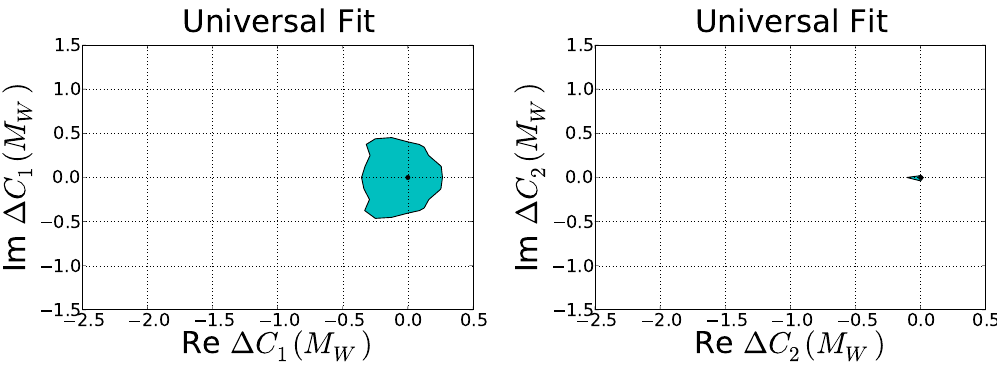
Figure 21 . Potential regions for the NP contributions (cid:1) C 1 ( M W ) and (cid:1) C 2 ( M W ) allowed by the observables used in our analysis at 90% C.L. assuming universal NP contributions. The black dot corresponds to the SM